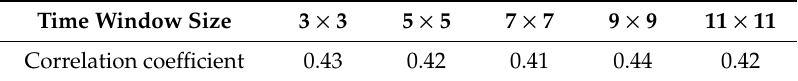
Figure 8. Horizon curve and mean curvature attribute with 20% noise: ( a ) Horizon curve and ( b ) mean curvature attribute of different time windows with 20% noise. Table 5. Correlation coefficient for different time windows with 20% noise.